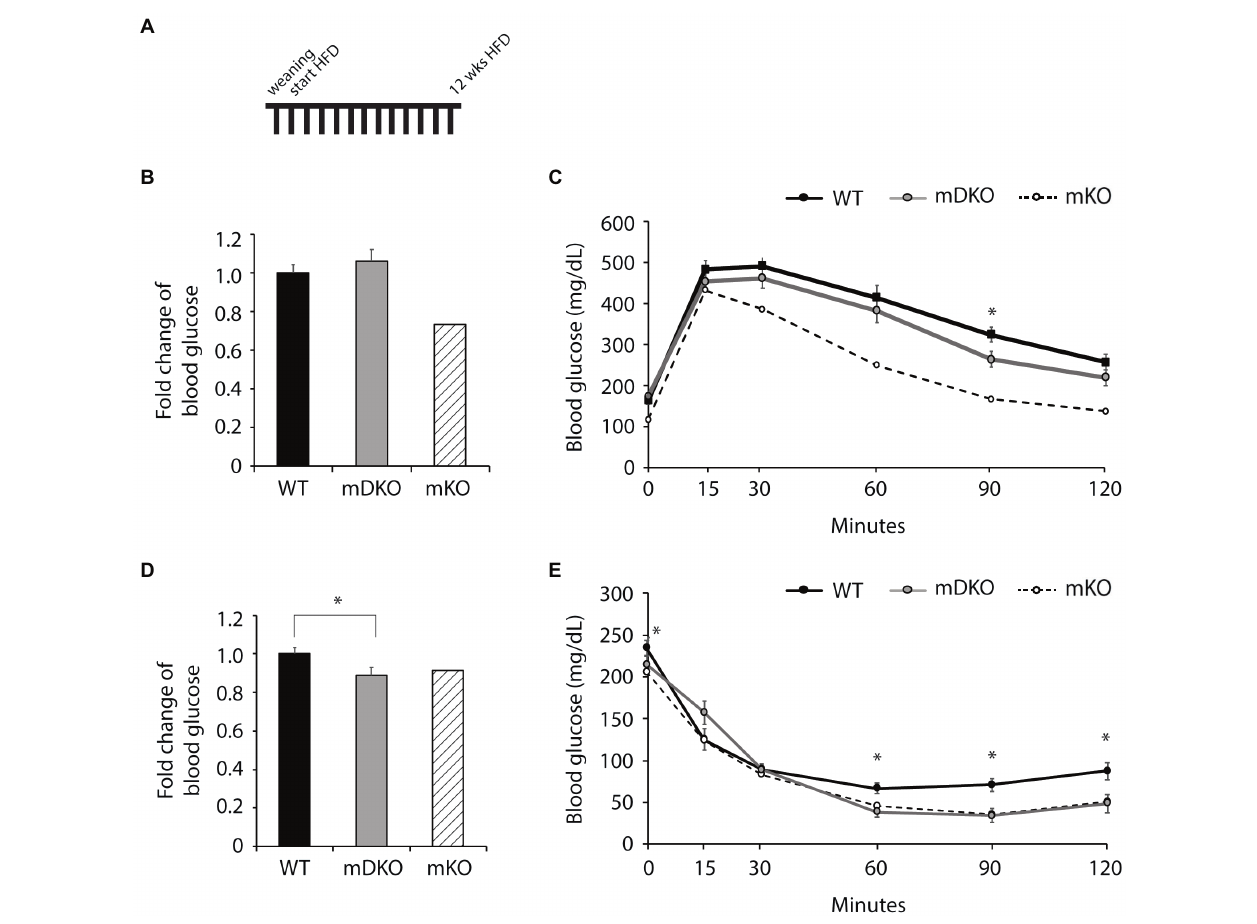
FIGURE 3 | Glucose and insulin tolerance testing after 12 weeks of HFD feeding. (A) Schematic of HFD-feeding. (B) Resting blood glucose levels after 16 h of fasting in WT and mDKO mice. Values are normalized to WT means. (C) Glucose tolerance test of WT and mDKO mice. Values are means ± SEM. (D) Resting blood glucose levels after 4 h of fasting in WT and mDKO mice. Values are normalized to WT means. (E) Insulin tolerance test of WT and mDKO mice. Values are means ± SEM, n = 12–13. * p < 0.05 when compared to WT. Values of striped bars are means from 5 muscle-specific OGT knockout mice (mKO) for